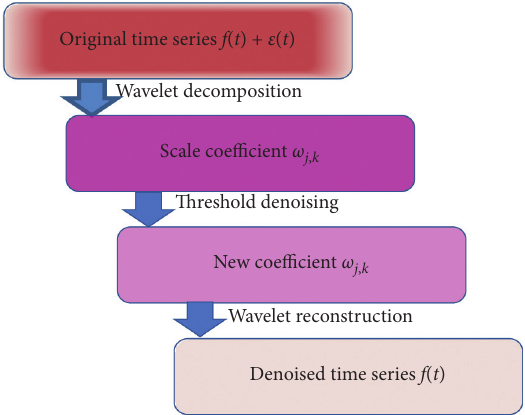
Figure 2: Wavelet denoising flow chart.